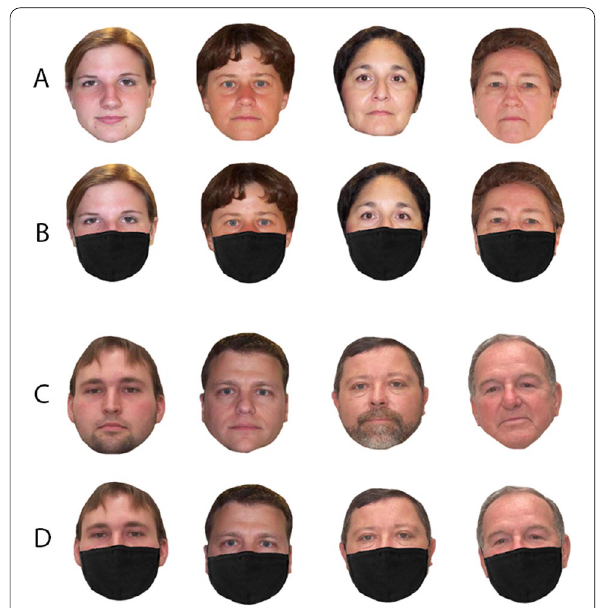
Fig. 4 Samples from the VISGRAF database used in the age estimation task. Top panel shows unmasked ( A ) and masked ( B ) female faces; bottom panel shows unmasked ( C ) and masked ( D ) male faces. Age range ascends from left to right: 20–29, 30–39, 40–49 and